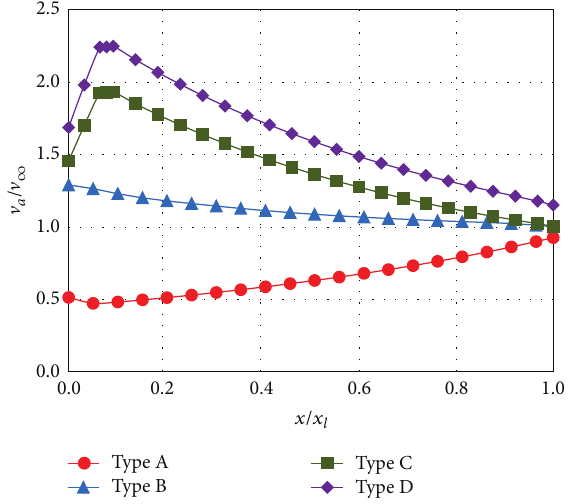
Figure 7: Velocity ratio